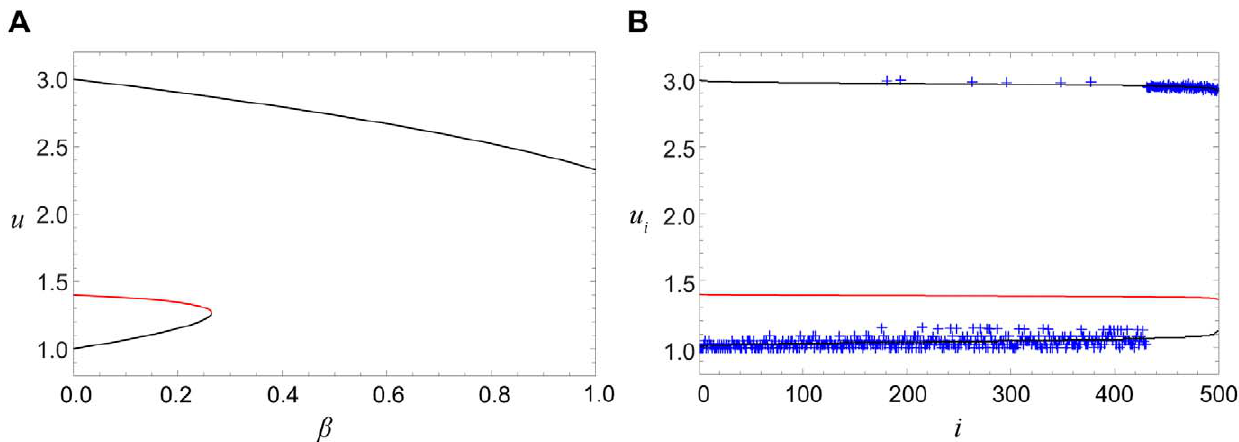
Figure 12. The stationary activity pattern and the mean-field bifurcation diagram. (A) The bifurcation diagram of Eq. (16) for the mean field Q ~ 1 : 5 . (B) Activity distribution in the stationary pattern in the ER network of size N ~ 500 and mean degree S k T ~ 7 at D ~ 0 : 01 is compared with the activator levels u predicted by the mean-field theory for Q ~ 1 : 5 . Blue crosses show the simulation data. Black and red curves indicate stable and unstable fixed points of the mean-field equation (16). The other parameters are r 1 ~ 1, r 2 ~ 1 : 4, r 3 ~ 3 .